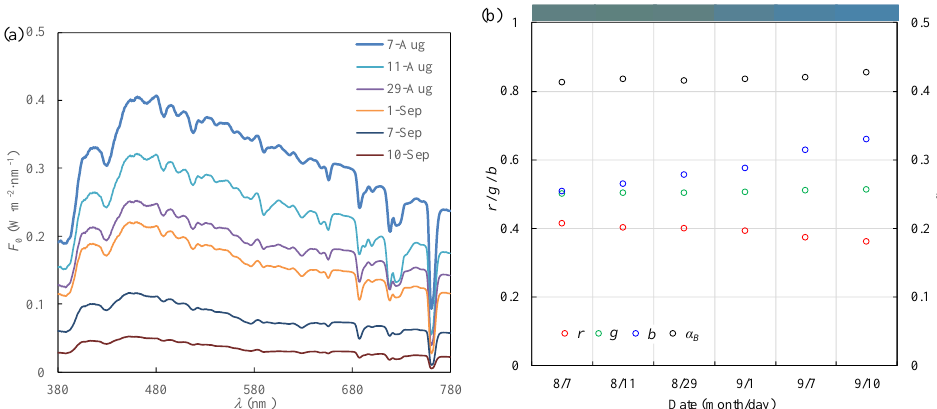
Figure 5. (a) Typical spectral incident solar irradiances in the Arctic summer under a completely overcast sky according to Grenfell and Perovich (2008) and (b) their influence on melt-pond albedo and the RGB intensities of pond color for H p = 0.3m and H i = 1.0m. The color bar on top of panel (b) denotes the simulated color of the melt pond under different sky conditions.